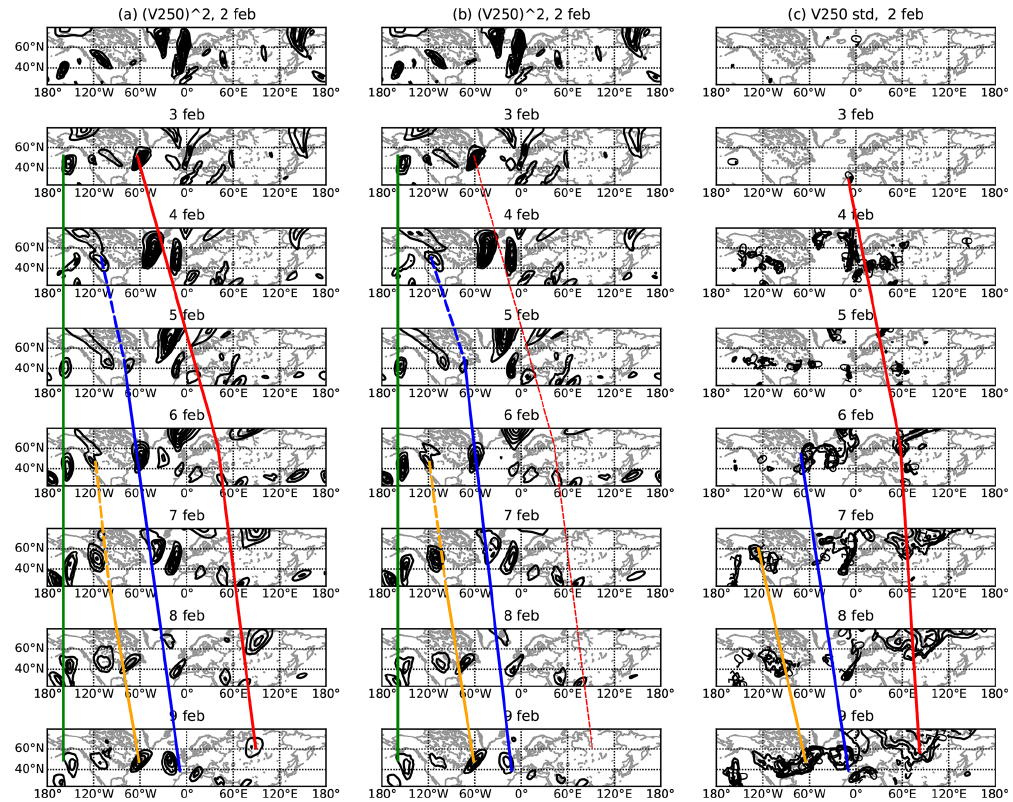
Figure 10. Same as Fig. 9b but for ENS + (a) and ENS − (b) members; contour intervals are 800m 2 s − 2 ; (c) standard deviation of the predicted 250hPa meridional wind velocity among ensemble members. The standard deviation is normalized by the maximum and minimum within the domain. Contour intervals are 0.1 starting from 0.5. The coloured lines are mostly similar to those in Figure 9 and suggest the propagation of wave packets. The red line in (b) is dashed to emphasize the lack of this wave train in ENS − . The green line in (c) is missing because there is little forecast spread in the eastern